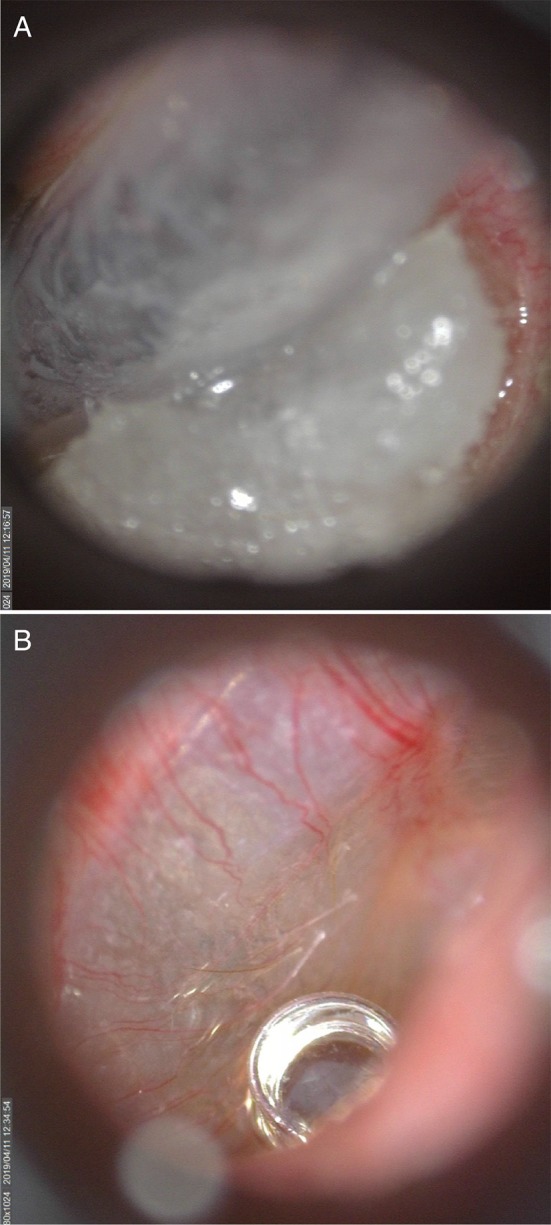
A commercially-available TM electrode in the ear canal (A) and Video otoscopic view of the University of Utah (U of U) TM electrode (B).